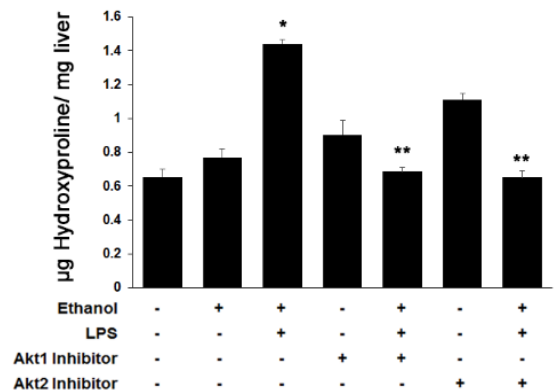
Figure 4. Role of Akt1 and Akt2 in ethanol and LPS-induced fibrosis. Liver tissue from various groups was used to determine hydroxyproline content (indicative of collagen fibers) to determine the extent of fibrosis. * p < 0.05 as compared to control, ** p < 0.05 as compared to EBL.